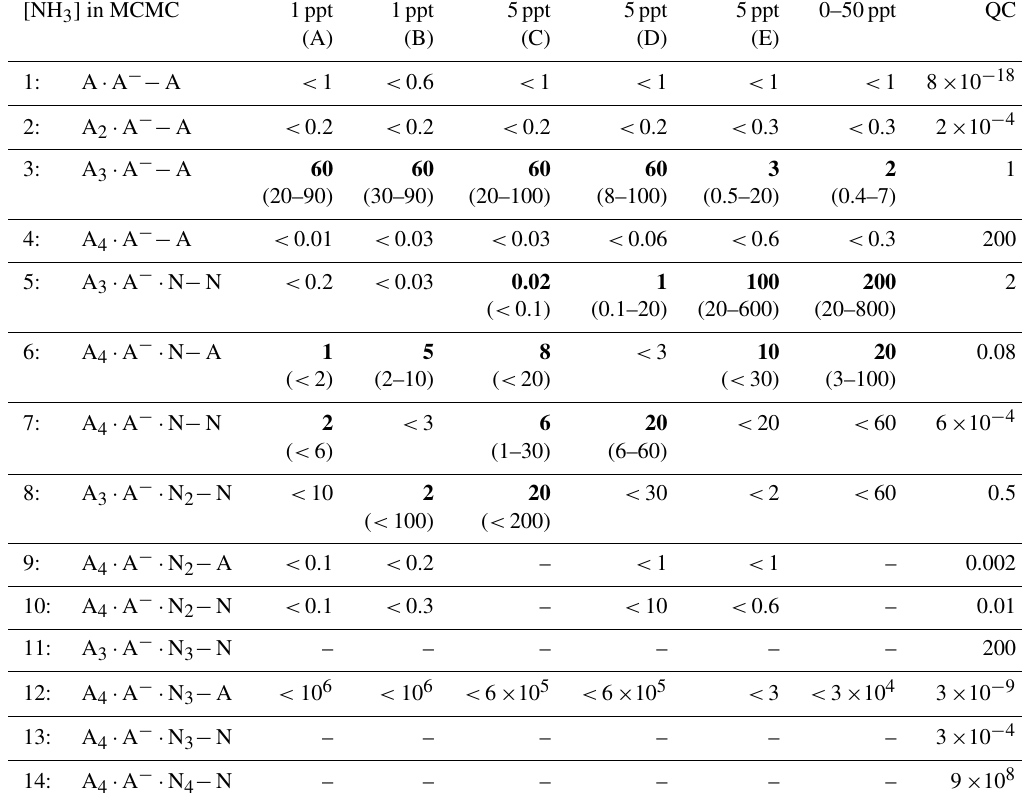
Table 1. Evaporation rates corresponding to the three MCMC simulations presented in Fig. 4. The cases where the background ammonia is set to a fixed value of 1 or 5ppt are divided into two and three alternative solutions, respectively, denoted as (A)–(E). (See the Supplement for more details.) For parameters that have a posterior distribution with a clear peak and practically zero probability density elsewhere, the location of the peak (bold face) is given together with the range of possible values in parentheses. In many cases only an upper limit can be determined, and some rates cannot be determined at all (–). The last column presents quantum-chemistry-based evaporation rates for comparison. In the reactions, “A” stands for H 2 SO 4 , “A − ” for HSO − and “N” for NH 3 4